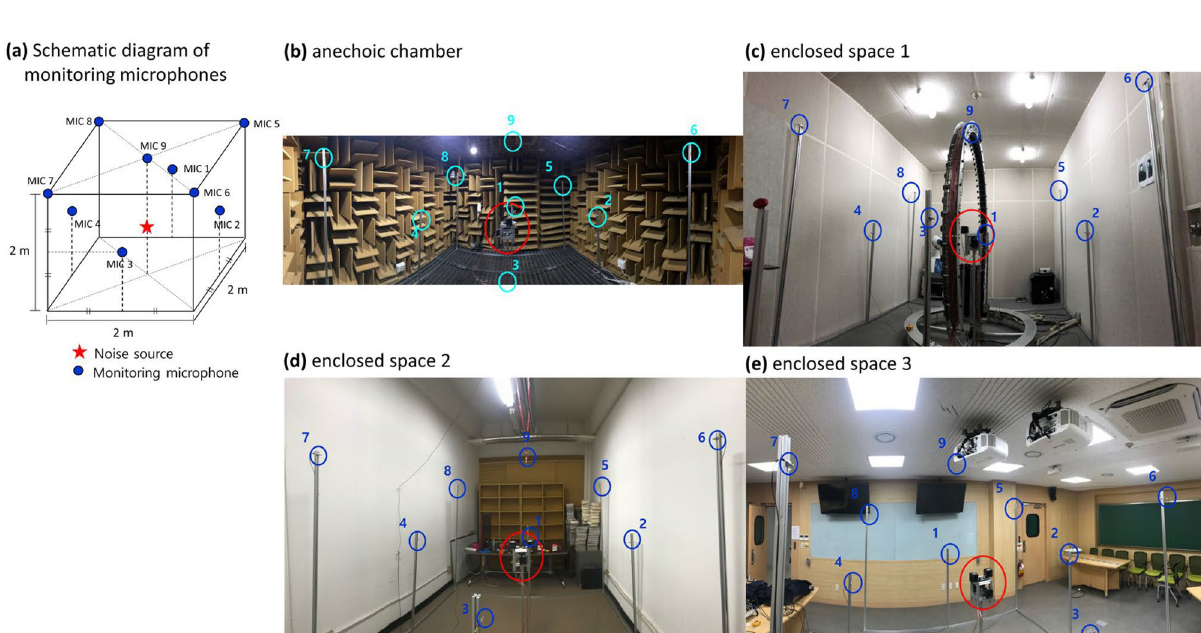
Figure 7. Schematic diagram of monitoring microphones and its experimental settings in each room. ( a ) Schematic diagram. ( b ) Anechoic chamber. ( c ) Enclosed space 1 (small size, small reverberation time). ( d ) Enclosed space 2 (small size, large reverberation time). ( e ) Enclosed space 3 (large size). Red circle is noise source and control speaker array. Blue circles are nine monitoring microphones for ANC control performance evaluation according to KS C IEC 60704-1: